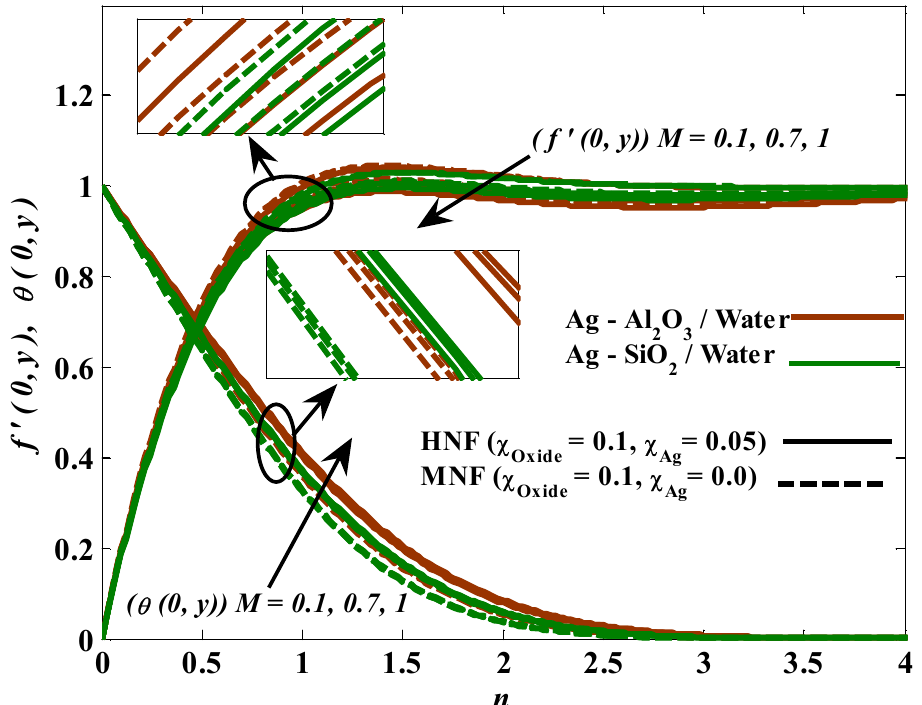
Figure 15. Illustration of M versus temperature and velocity at fixed values of λ = 0.2, R = 0.1, & We =